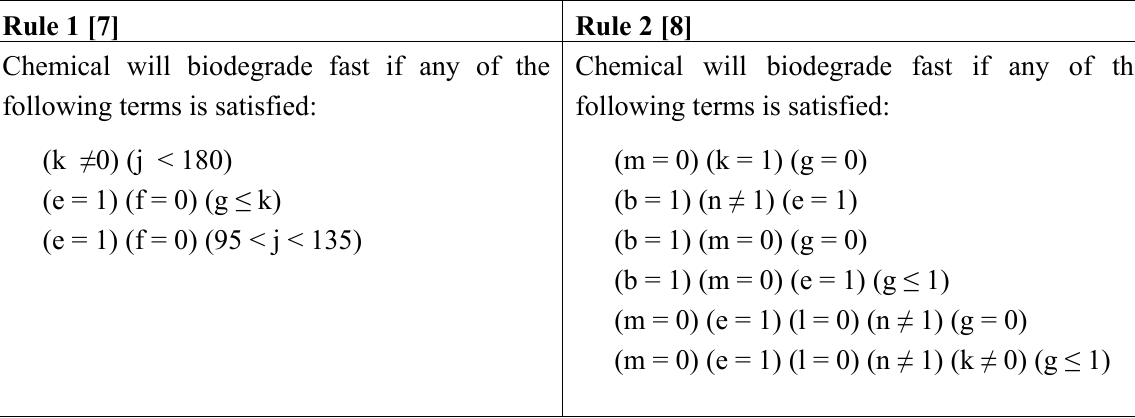
Table 5. Mathematical representation of two Rules developed by Gamberger et al . (See Table 3 for structural descriptors with letter designations)